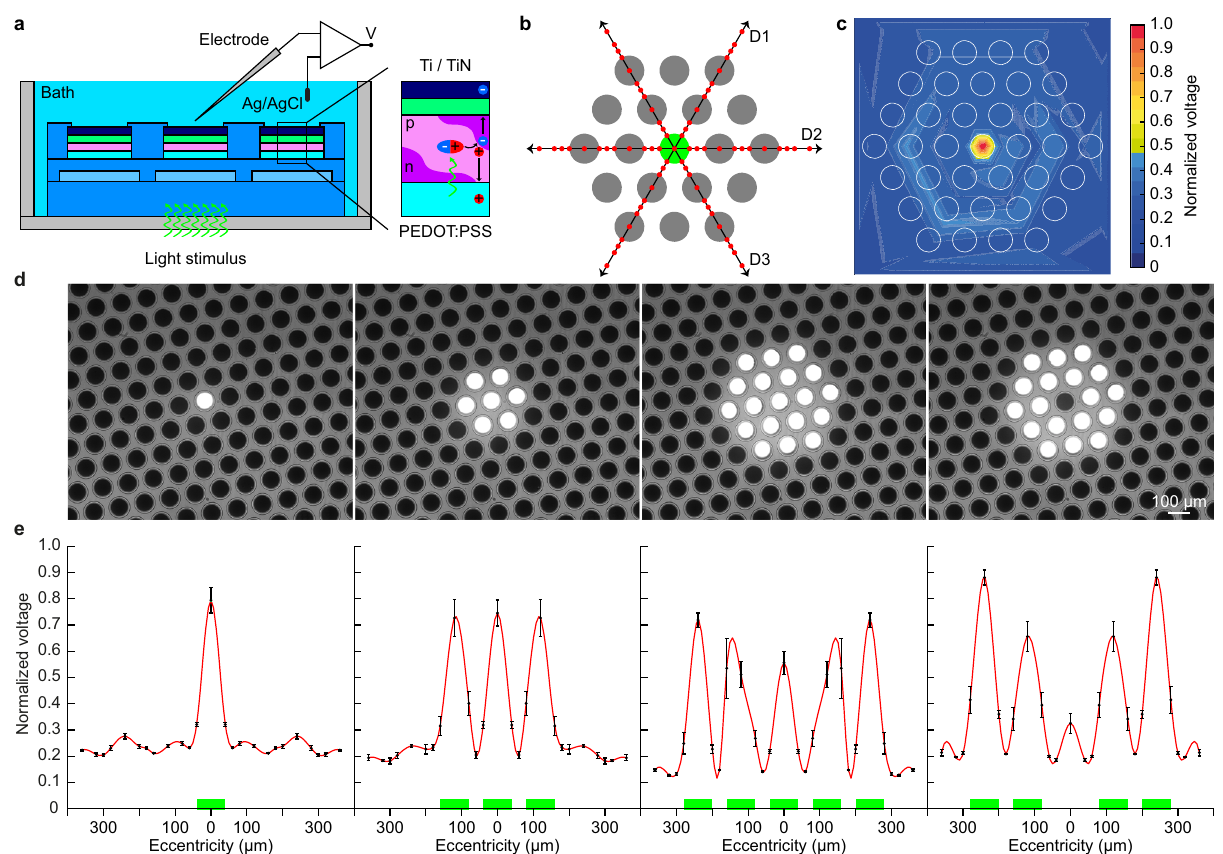
Fig. 2 Stimulation selectivity of the photovoltaic pixel. a Sketch of the experimental setup to measure the voltage spreading. The insert shows the photovoltaic transduction mechanism. A photon is absorbed by the P3HT (p-type semiconductor, electron donor) and an exciton is formed. The exciton travels until it reaches the interface between P3HT and PCBM (n-type semiconductor, electron acceptor) and dissociates. The electron is attracted towards the cathode (Ti/TiN), and the hole is attracted towards the anode (PEDOT:PSS) because of their work function levels. b Sketch of the experimental methodology. The green dot corresponds to the illuminated pixel (560 nm, 10 ms, 22 mW mm − 2 ). The grey ones represent the surrounding pixels. The voltage was measured in 25 positions (red dots) for each direction (D1, D2 and D3). c Voltage spreading colour map generated by interpolating the experimental measures with a triangulation-based linear interpolation. For each data point, ten consecutive recordings were averaged and the voltage peaks were normalised to the maximal value obtained in the whole experiment. The white circles show the location of the pixels. d Pictures of the four stimulation patterns: central on (left), central on and one corona on (middle left), central on and two coronas on (middle right), and central off and two coronas on (right). The light spots are visible (brighter area). e Normalised voltage pro fi les obtained for the four illumination patterns (mean ± s.e.m.; n = 4 prostheses). For each prosthesis, the normalised data from the three directions were averaged. The red line shows a Gaussian fi tting, and the green bars beneath corresponds to the active